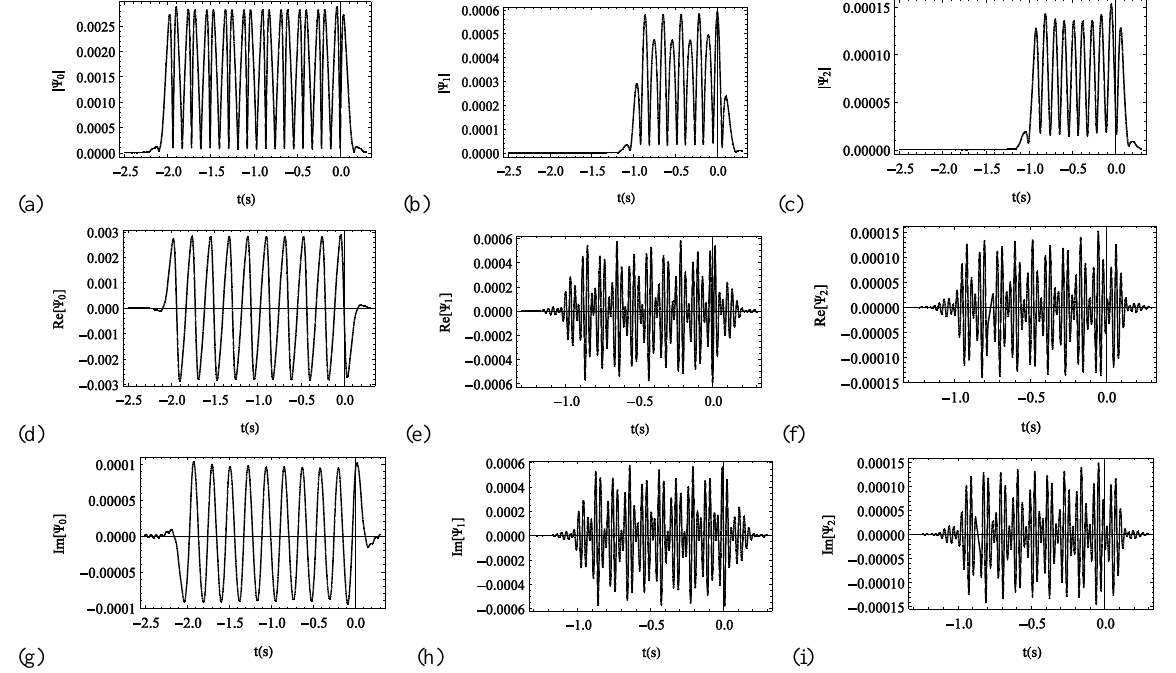
Fig. 5. Terms of Adomian’s decomposition for the angular rotation: